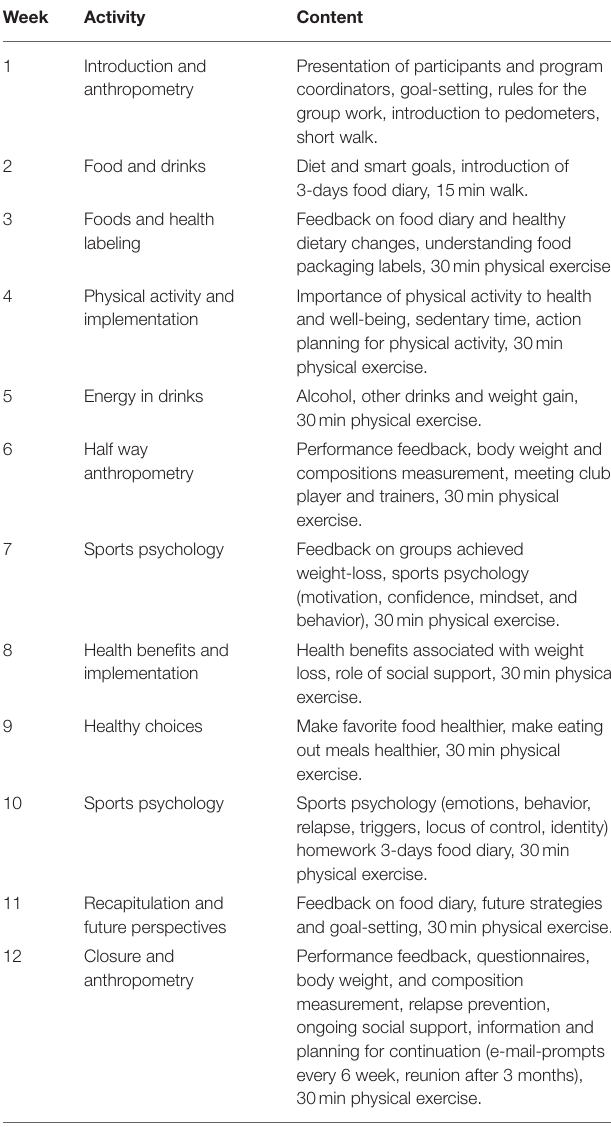
TABLE 1 | The 12-week intervention